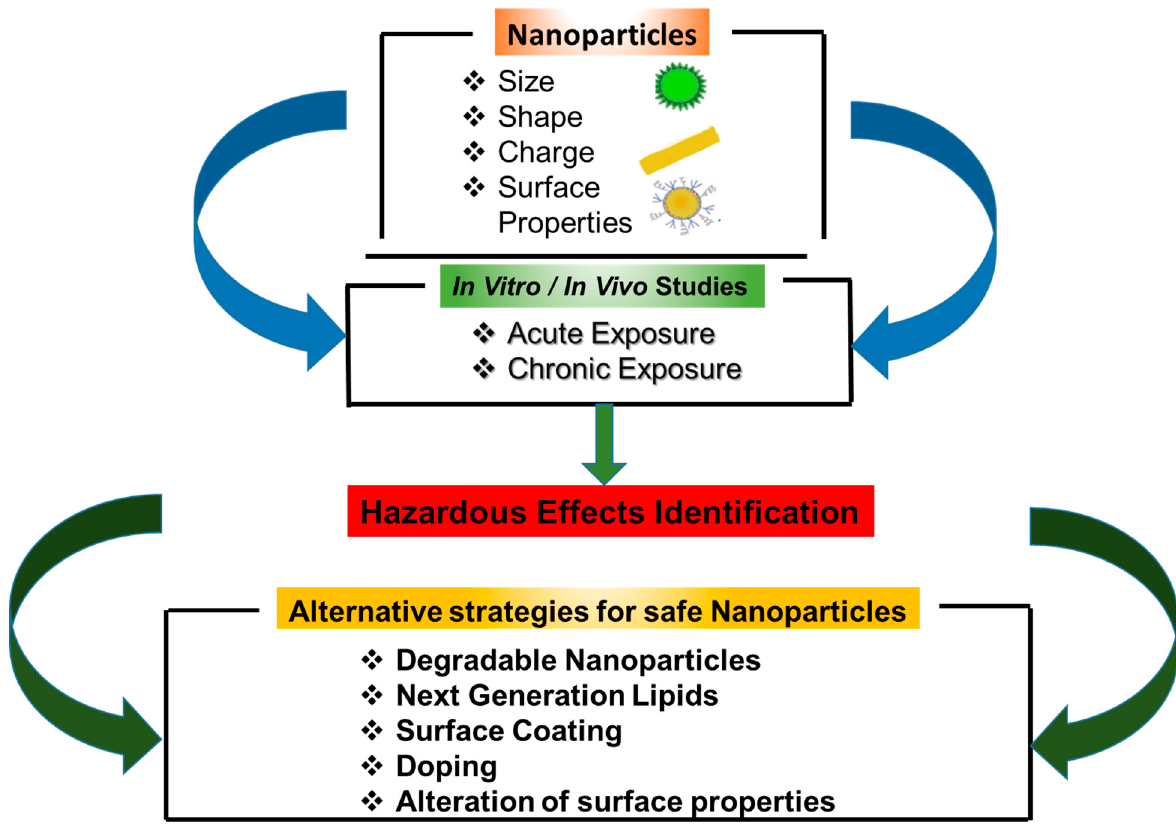
Figure 5. Strategies for safer nanoparticles. Effective strategies start from choosing the right physicochemical properties of NPs. Once studies show potential risks then alternative strategies may include modifications of the composition or surface functionalities in addition to other strategies discussed in the text.